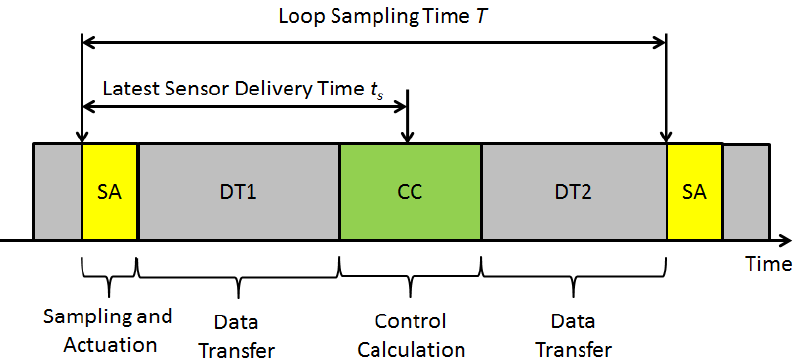
Figure 2. Loop Timing with Approximately Synchronized